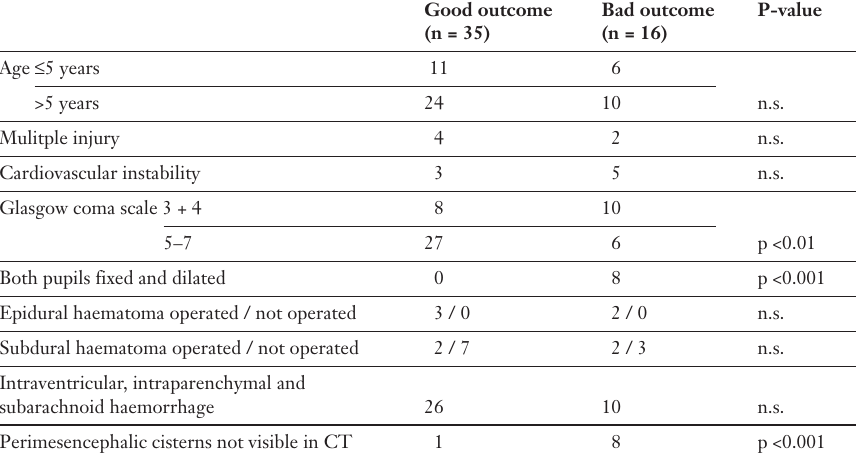
Clinical and comput- erized tomography findings and out- come (n =